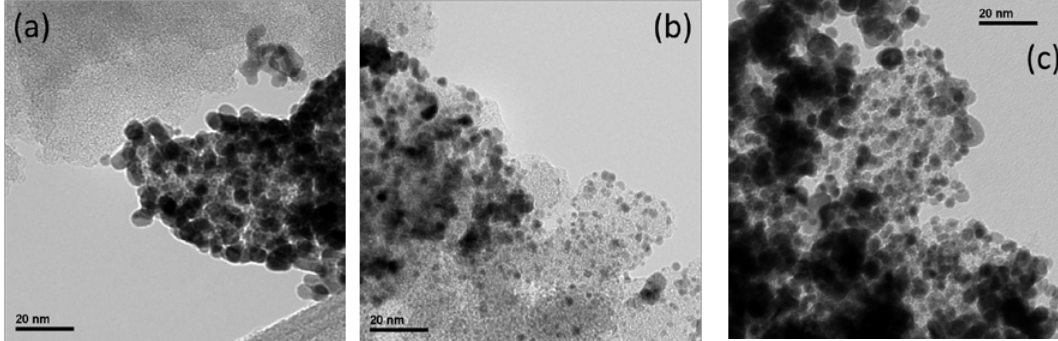
Figure 4. TEM micrographs for carbon xerogels (CXG)-supported Pt catalysts: ( a ) Pt/CXG-130; ( b ) Pt/N-CXG-130; and ( c ) Pt/N-CXG-300.